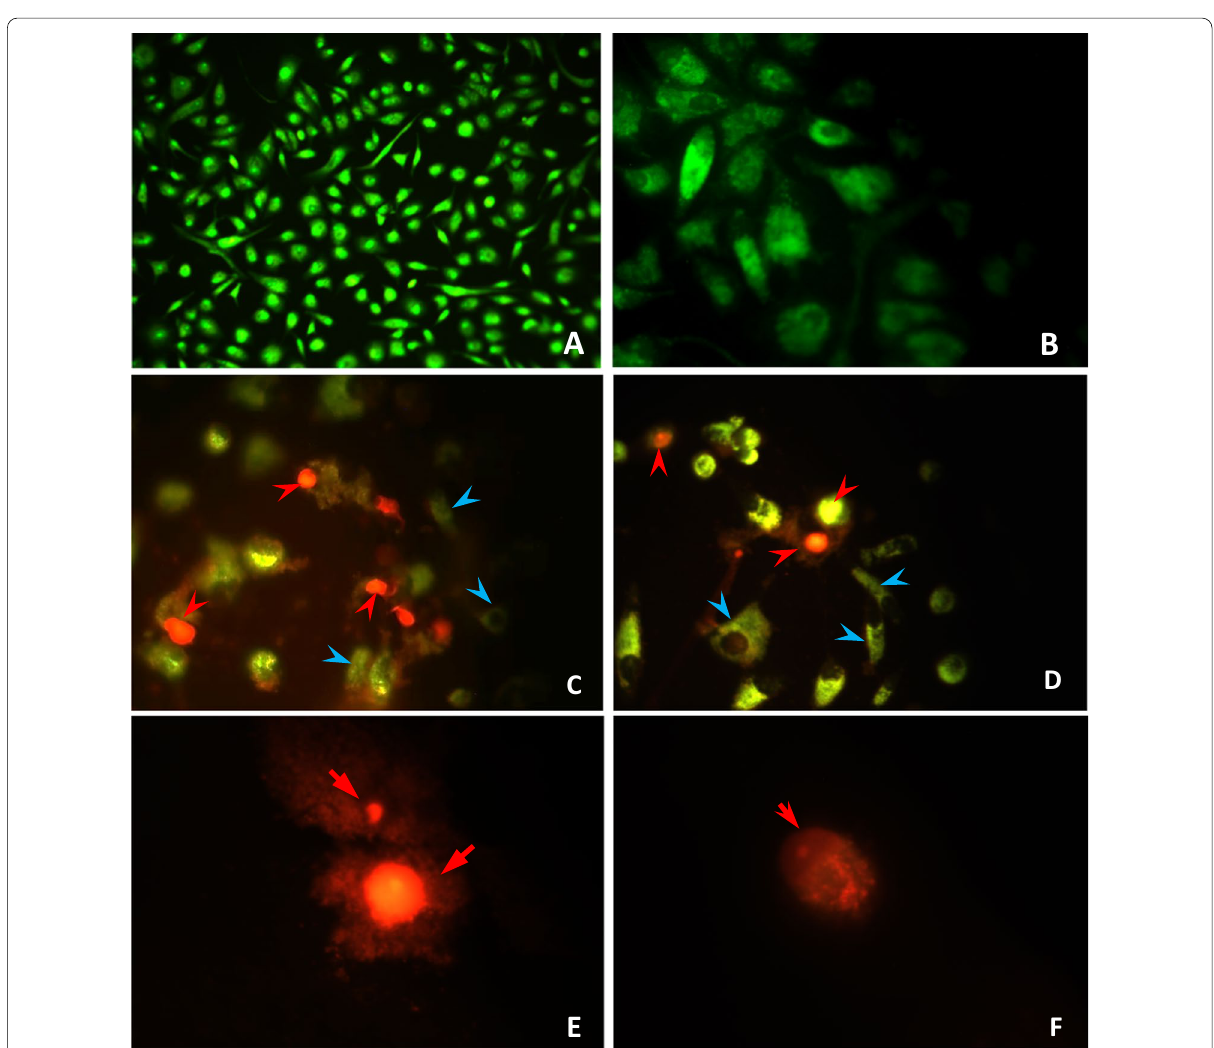
Fig. 4 Morphological analysis of SK‑GT‑4 cells line following acridine orange/ethidium bromide staining. A Untreated cells 40. C Treated cells with IC50 of EU, the viable cells (blue head arrows), the apoptotic cells (red head arrows) × the proapoptotic and apoptotic cells (red head arrows), the viable cells (blue head arrows) (red head arrows) 100. F Treated cells with IC50 of RA, the apoptotic cells (red head arrows) ×